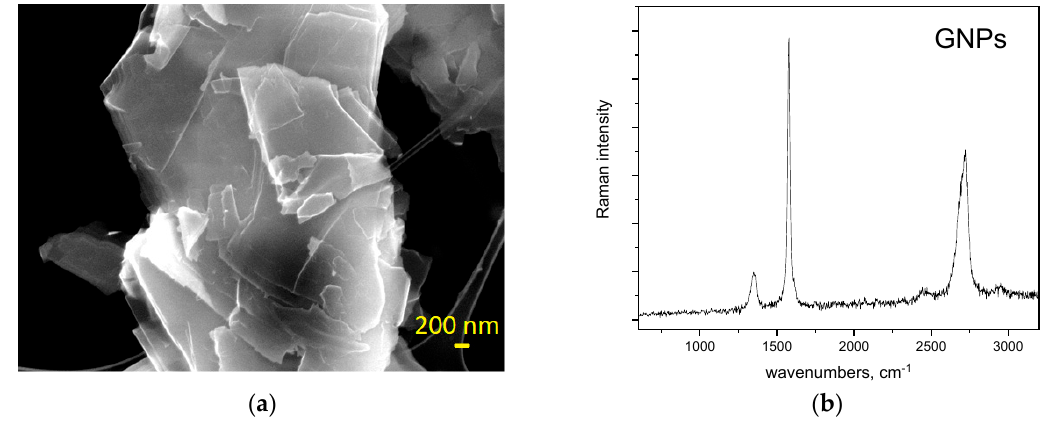
Figure 4. ( a ) SEM images of GNPs and ( b ) Raman spectra of the GNPs. Different procedures were tested for the growth of CNTs on chopped CF surface. As displayed in Figure 5, the CFs grafted by the floating catalyst approach were homogeneously coated with thin CNTs, surrounding each monofilament.